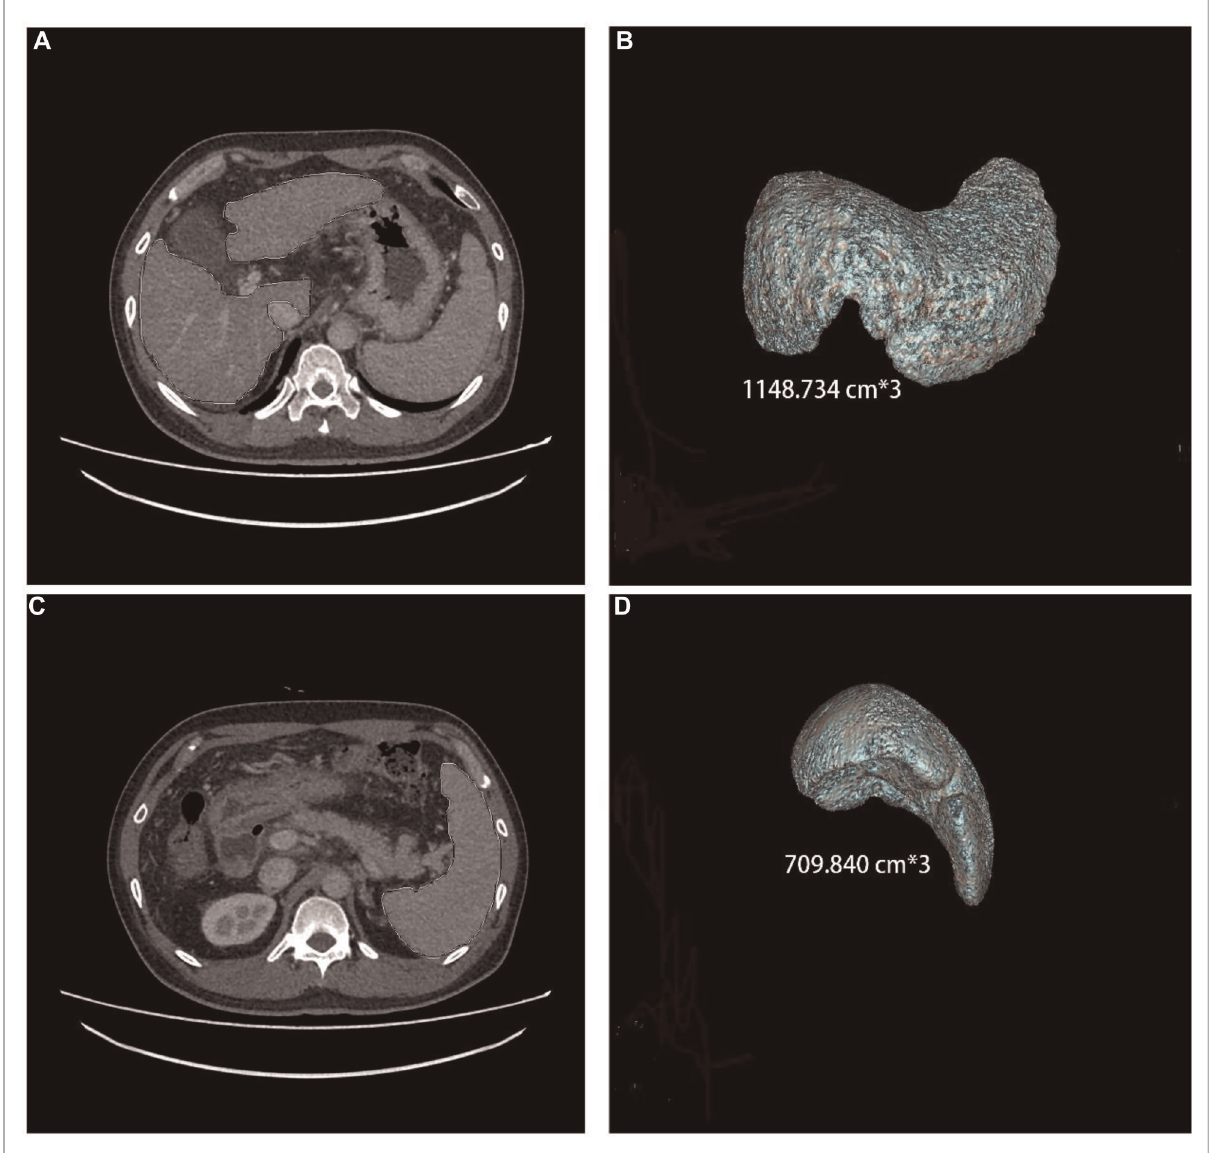
FIGURE 1 Liver and spleen volume, as measured by CT, in a 44-year-old male who has had hepatitis B cirrhosis for 20